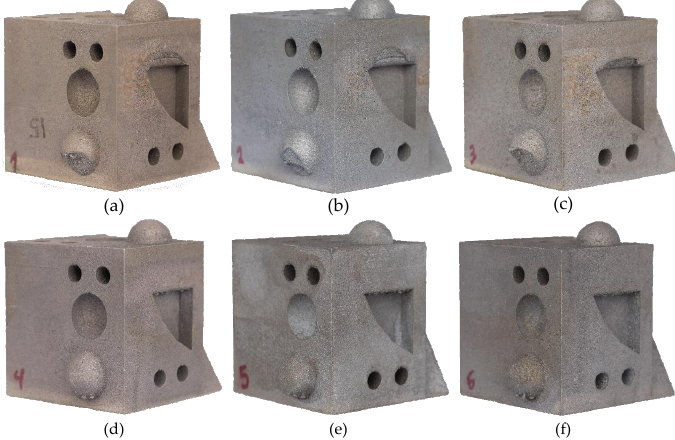
Figure 3. Final part examples from each sample set, showing the effects of using build support material onoverhang features; ( a ) example fromSample_Set_01, builtwitha chessboard strategy, 15 µm layerand no support material ; ( b ) example fromSample_Set_02, builtwitha continuous strategy, 15 µm layer and no support material; ( c ) example from Sample_Set_03, built with a chessboard